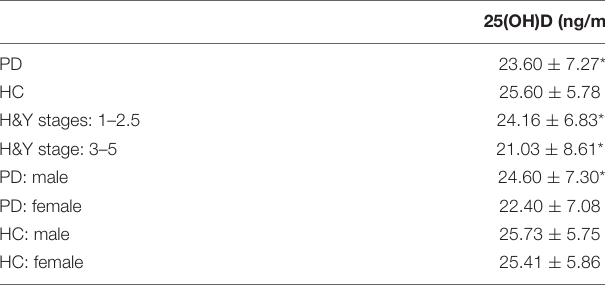
TABLE 2 | Serum 25(OH)D levels in different populations.